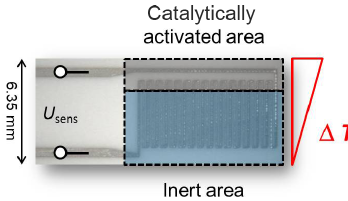
Figure 1. Sensor setup: screen-printed thermopiles (Pt / PtRh on alumina substrate) allow a thermovoltage U sens to be measured be- tween the inert and the catalytically activated area of the sensor. This voltage is a function of exothermicity. A heater on the reverse side adjusts the absolute sensor